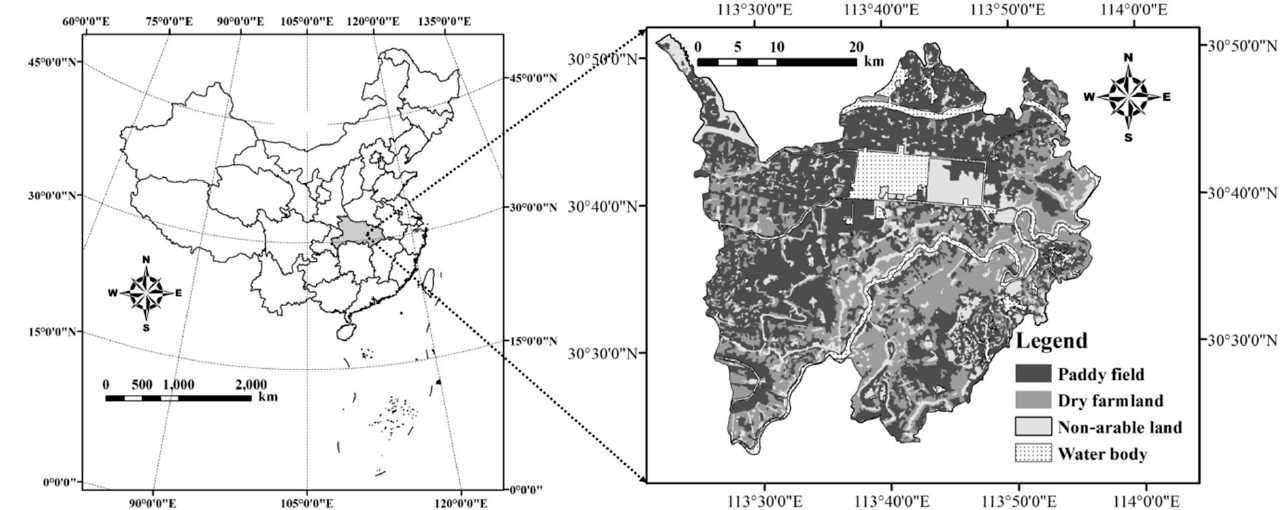
Figure 1. Location of the study area and the land-use type map.